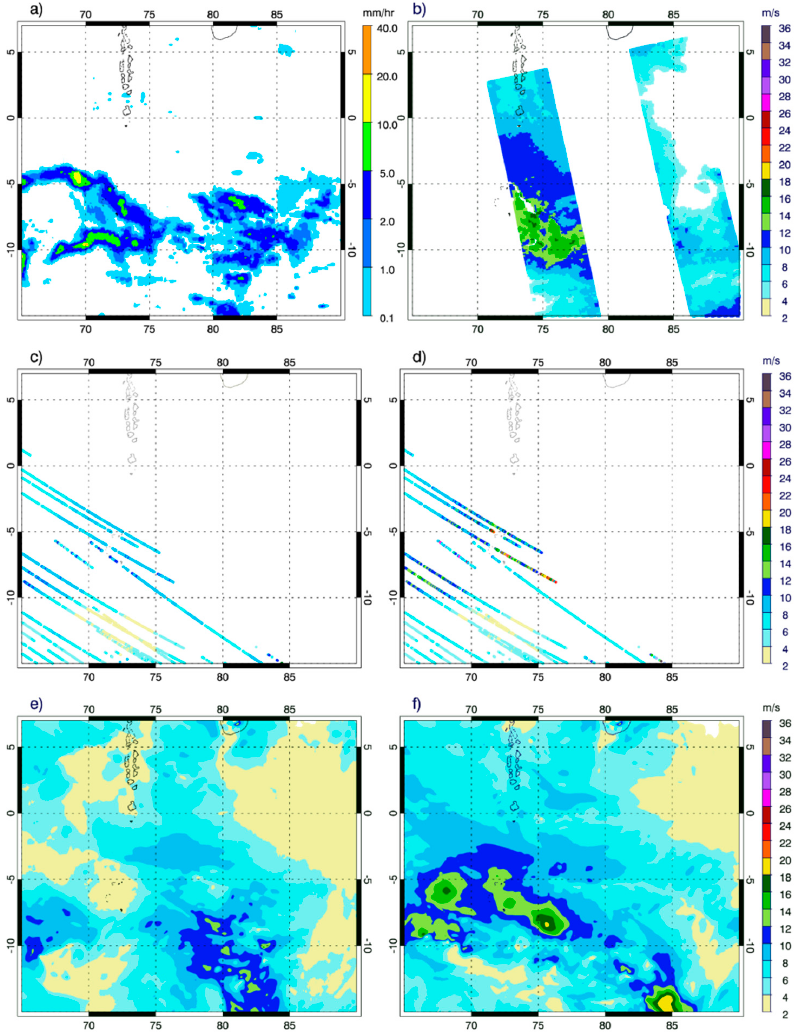
Figure 9. ( a ) IMERG precipitation for the WWB event at 1500 UTC on 8 January 2018, ( b ) ASCAT wind speed around 1436 UTC on 8 January 2018, ( c ) CYGNSS FDS and ( d ) YSLF wind speed around 1500 UTC on 8 January 2018, and surface wind speed from ( e ) CTRL and ( f ) DA_cyg_lf at 1500 UTC on 8 January 2018.